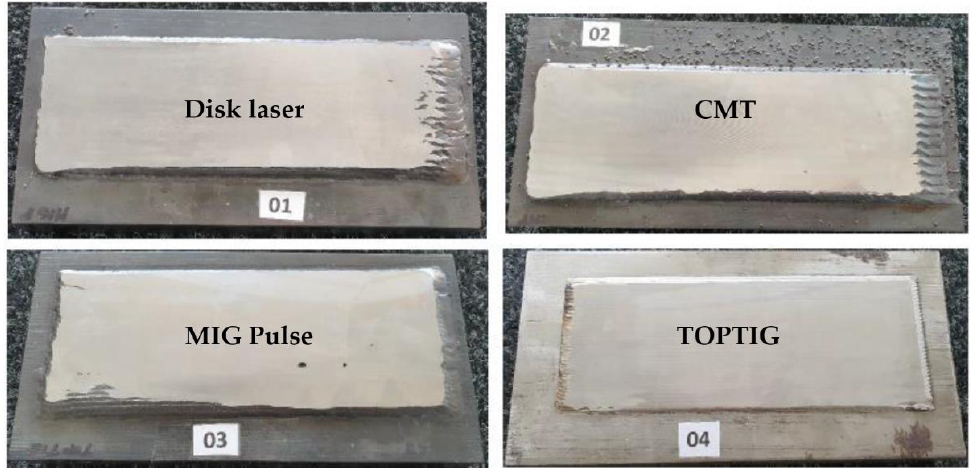
Figure 3. Samples after heat treatment and subsequent